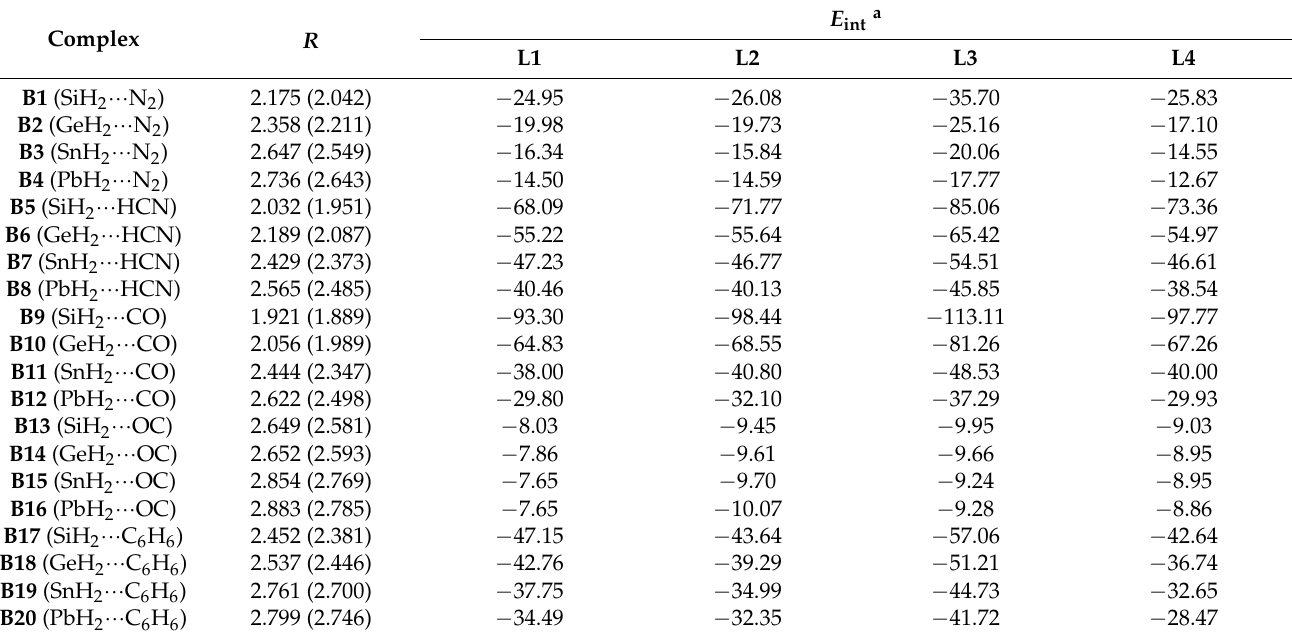
Table 4. Binding distance at MP2/aug-cc-pVDZ and MP2/aug-cc-pVTZ (in parentheses) levels ( R , in Å) and interaction energy at various levels ( E int , in kJ/mol) for type-B complexes.